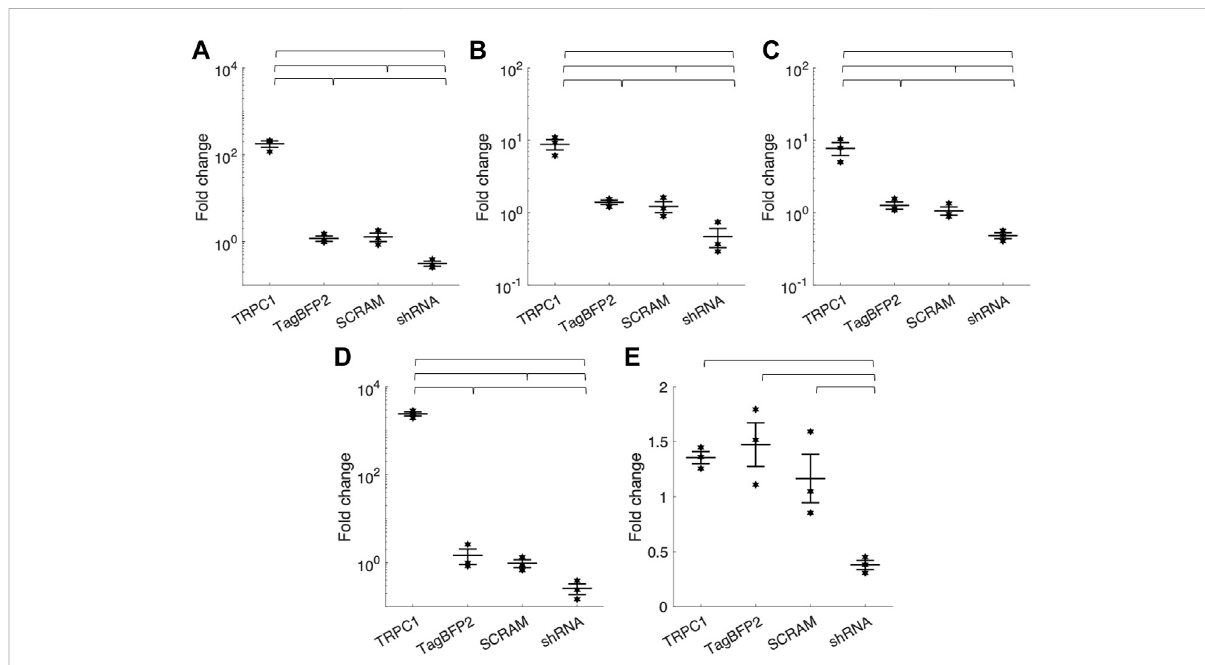
Mean fold change of TRPC1 mRNA expression of infected NRVMs from WT NRVMs quanti fi ed by RT-qPCR with primers targeting rat TRPC1 (A) exon 3-4 (Rn00677552_m1) (B) exon 6-7 (Rn00677554_m1) (C) exon 8-9 (Rn00585625_m1) (D) exon 10-11 (Rn00677549_g1) and (E) exon